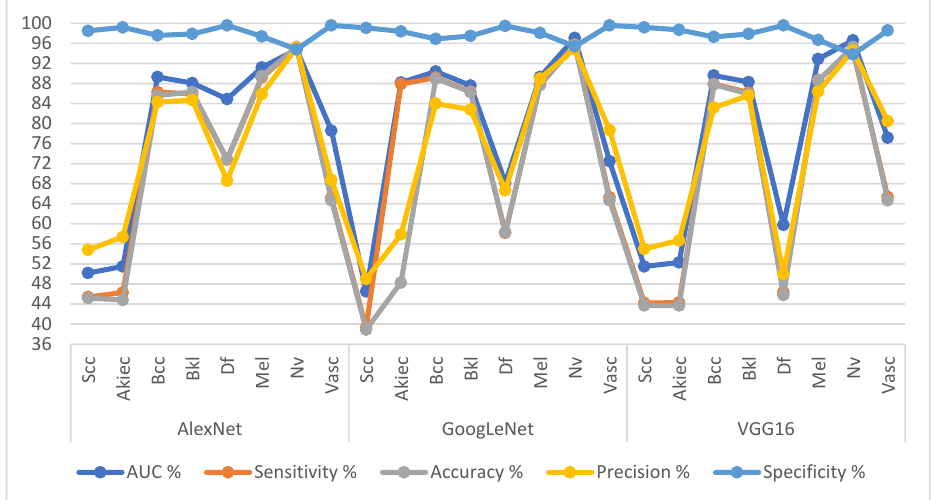
Figure 7. Display performance results of pre-trained CNN models for analysis of the ISIC 2019 dataset image for early diagnosis and distinction of skin cancer and other skin lesions.